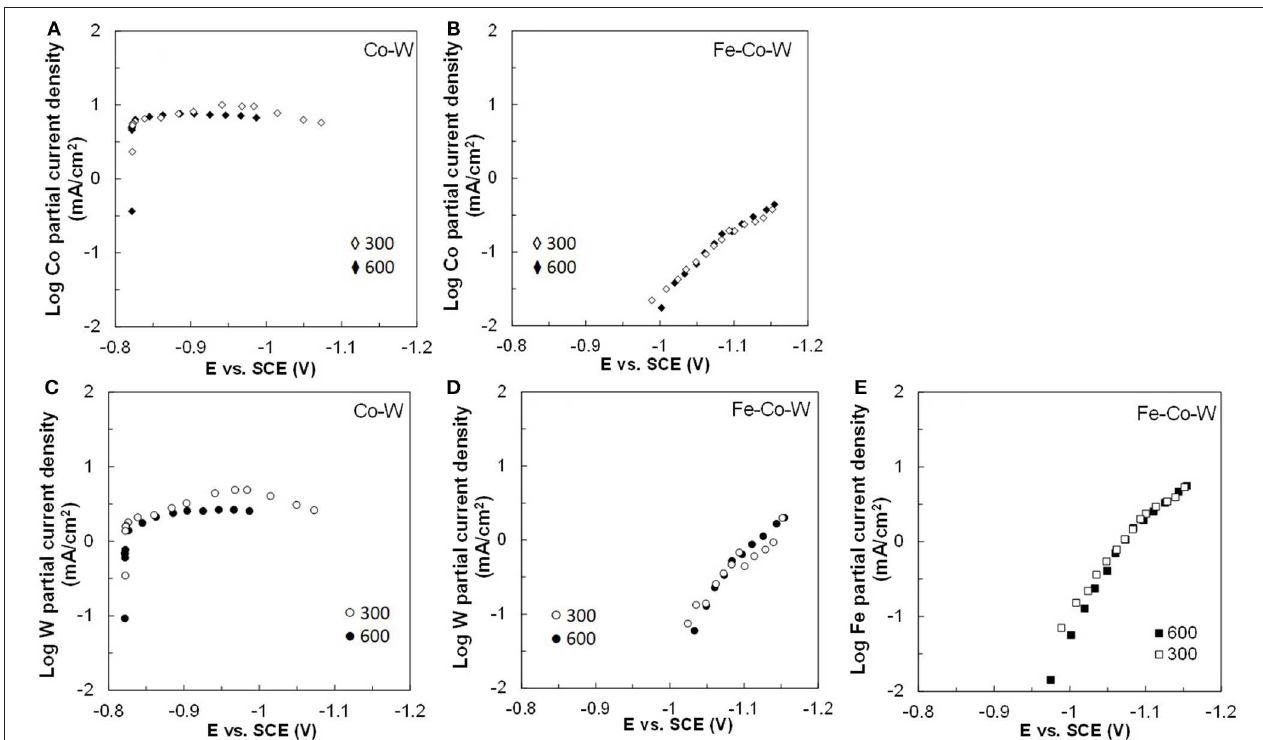
FIGURE 6 | Partial current densities of (A,B) Co, (C,D) W, and (E) Fe in Co–W and Fe–Co–W electrolytes at 23 ◦ C and at an electrode rotation rates of 300 and 600